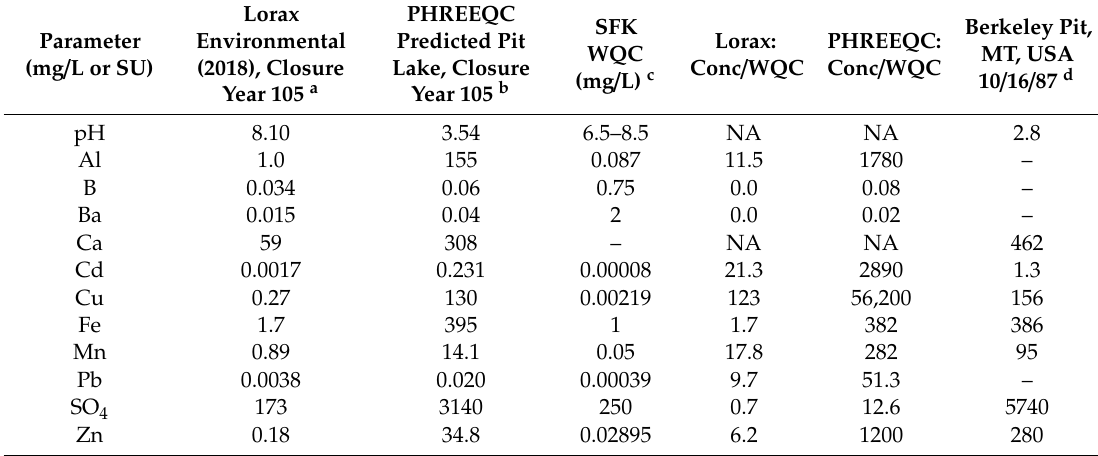
Table 4. Comparison of Lorax Environmental and PHREEQC-predicted (this study) Pebble pit lake chemistry with Pebble Project water quality criteria, and measured Berkeley Pit water quality.